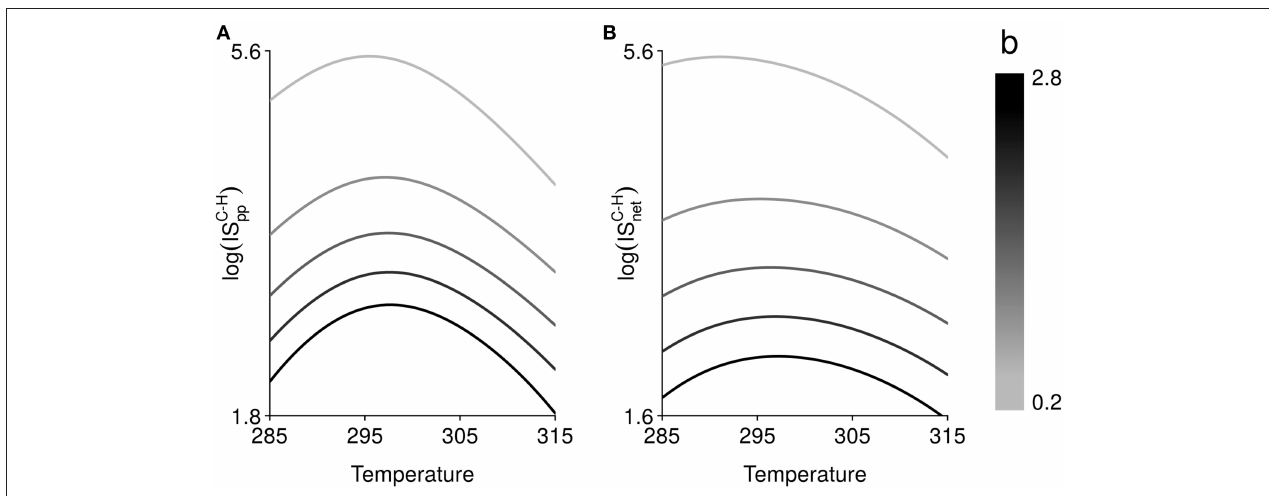
FIGURE 4 | Effect of temperature (in Kelvin) on, (A) , interaction strength per population, IS C − H pp , and, (B) , net interaction strength, IS C − H net , between carnivores C and herbivores H. The relationship between temperature and both interaction strength measures is hump-shaped and follows the thermal dependence function of search rate (or per capita interaction strength) and growth rate ( Figure 2 ). Varying the mortality rate, from 0.2 to 2.8 time –1 , changes the magnitude of the temperature effect, the relative strength of interaction and shifts the temperature at which interaction strength is